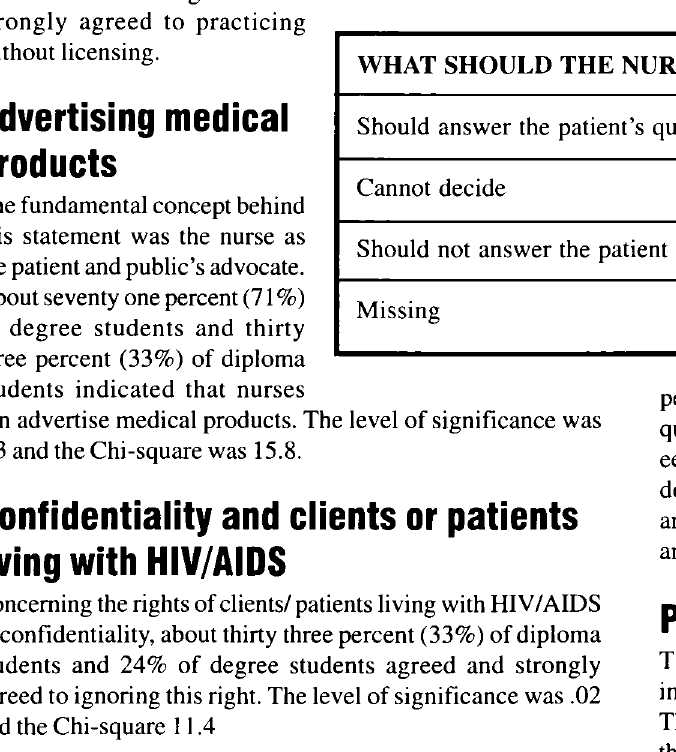
Table 3: Frequency scores in response to “ What should the nurse